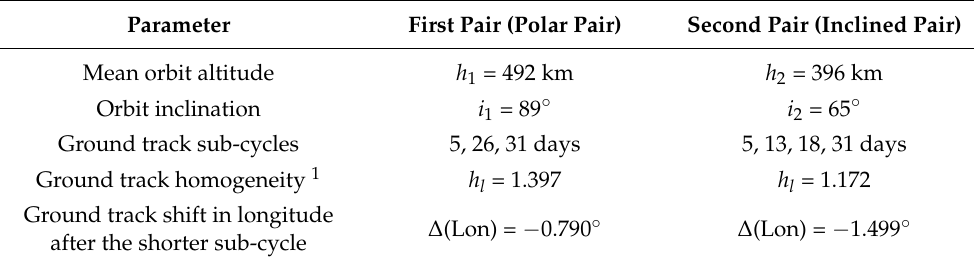
Table 2. Orbital parameters of a Bender constellation suitable for the